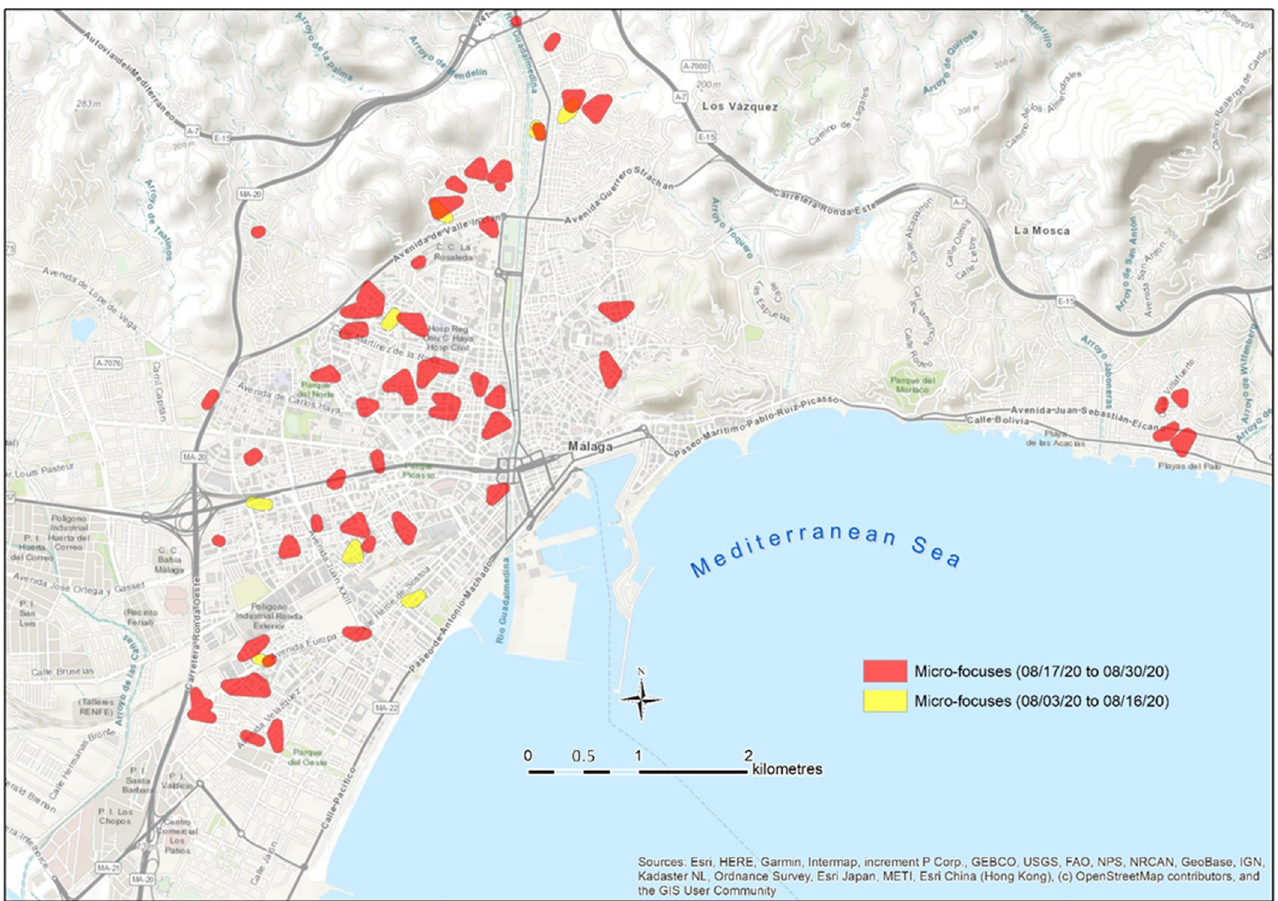
Figure 10. Superposition of the contagion micro-focuses in the city of M á laga in two successive bi-weekly periods during the month of August.